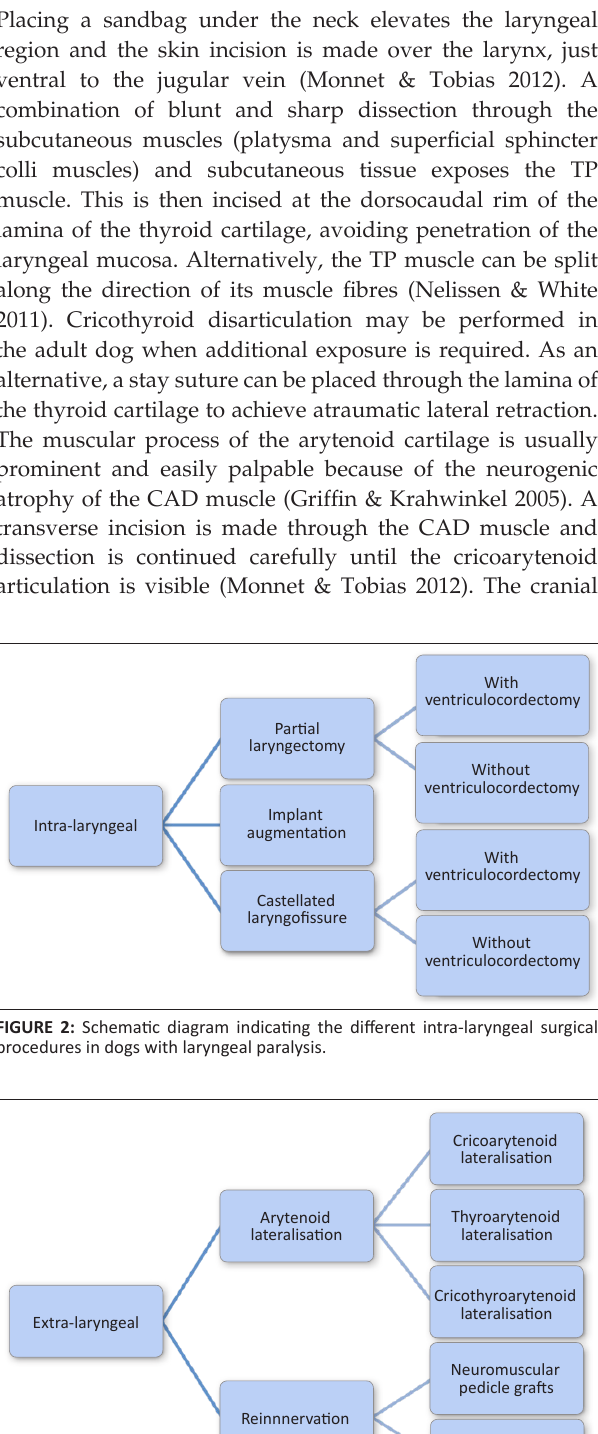
Extra-laryngeal